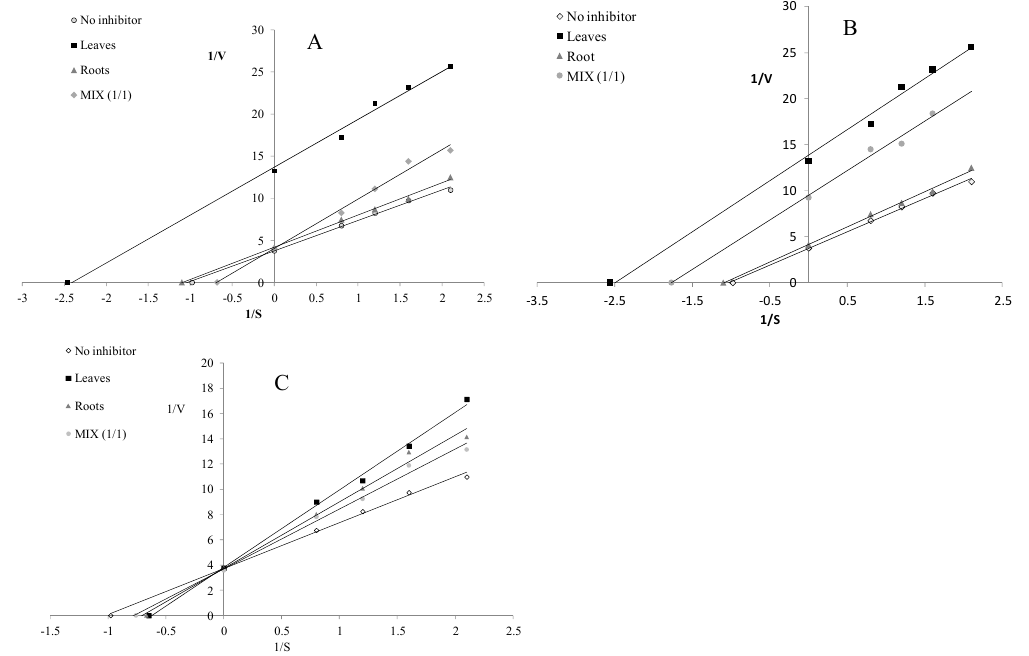
Figure 4. Mode of lipoxygenase inhibition by extracts from the leaves and roots of S. aloides . ( A )—infusions, ( B )—extracts after digestion in vitro, ( C )—extracts after absorption in vitro.